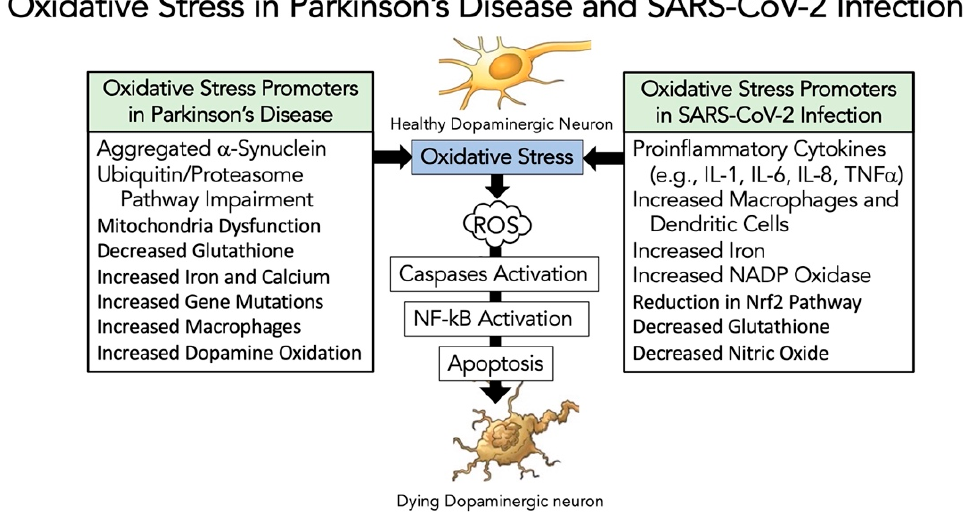
Figure 2. Overview of oxidative stress in PD and in SARS-CoV-2 infection. Abbreviations used: ROS, reactive oxidative species; NF-kB, nuclear factor kB; IL, interleukin; TNF, tumor necrosis factor; NAD, Nicotinamide adenine dinucleotide phosphate; Nrf2, nuclear factor-erythroid factor 2-related factor 2; ROS, reactive oxygen species.